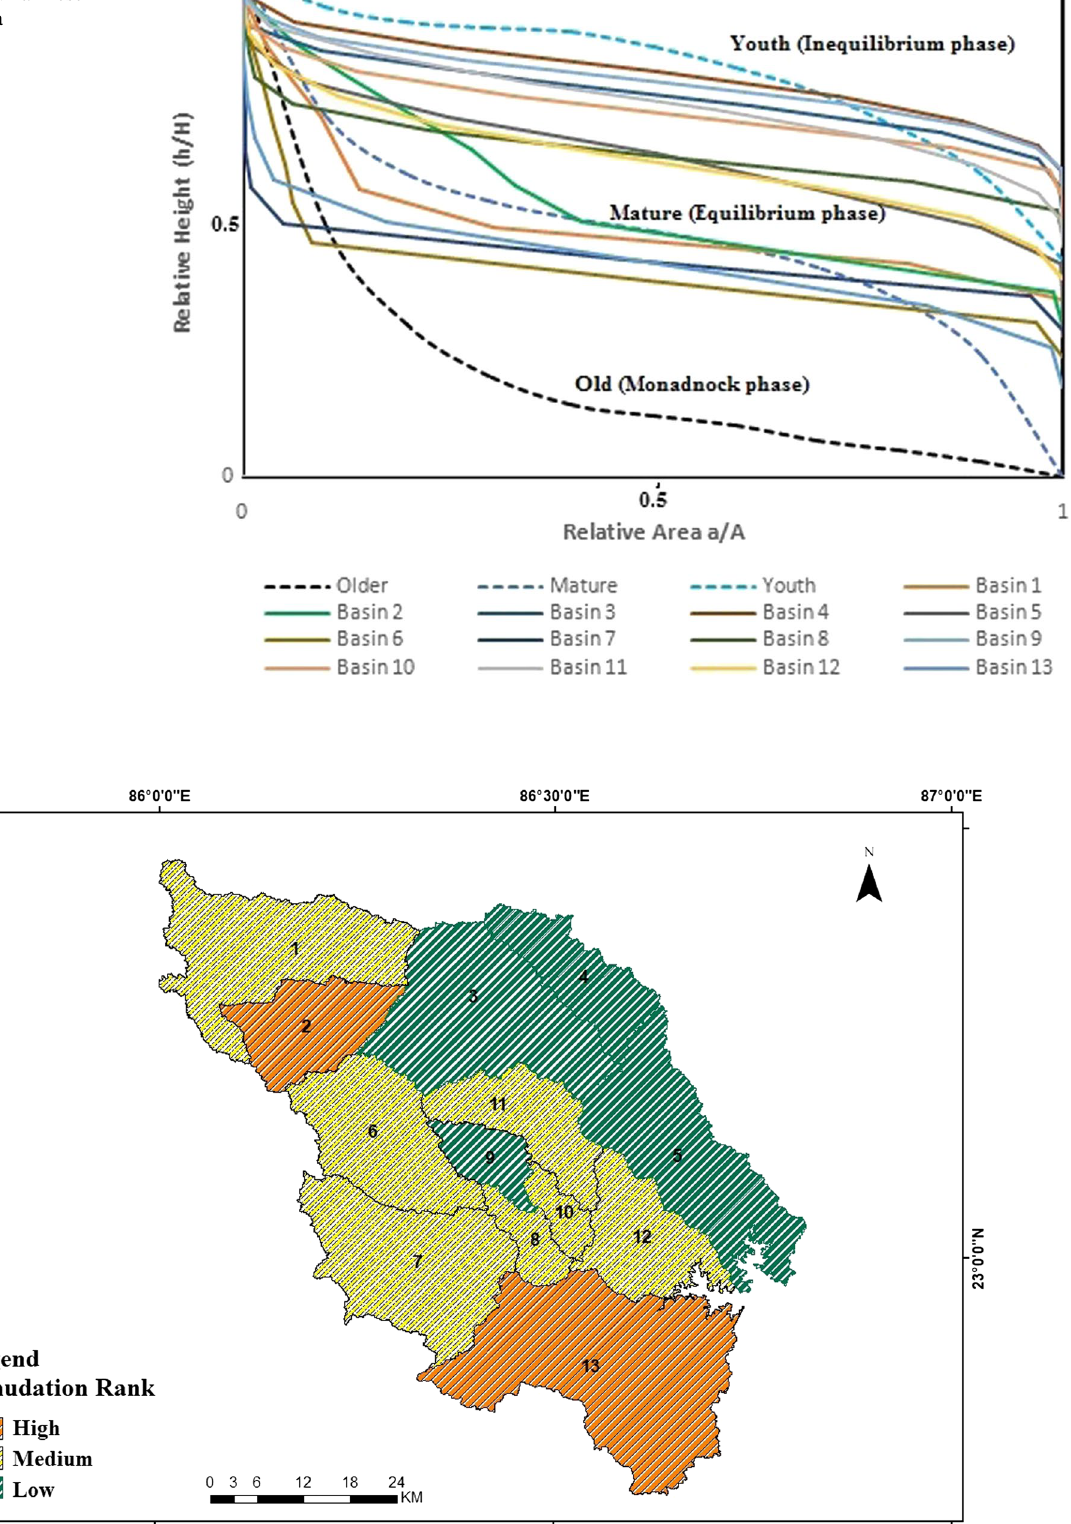
Fig. 11 Hypsometric integral value in Kansai–Kumari reser- voir catchment area